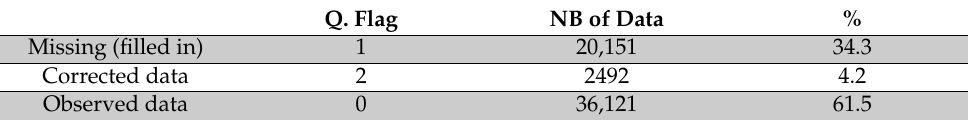
Table 2. Data characteristics after homogenization.